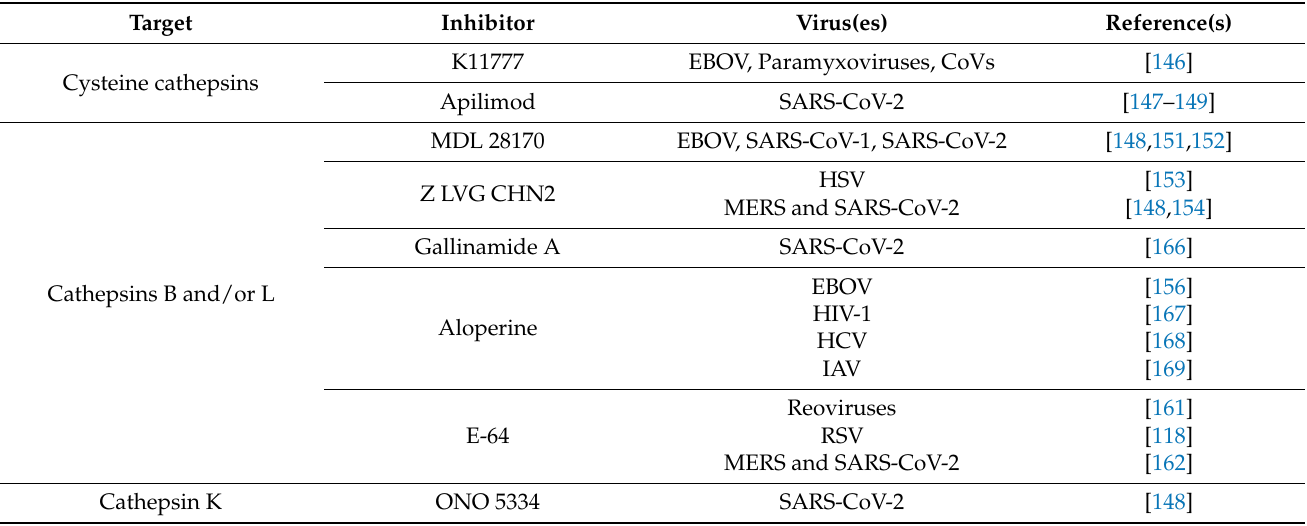
Table 2. Examples of effective cathepsin inhibitors for the treatment of infection diseases caused by